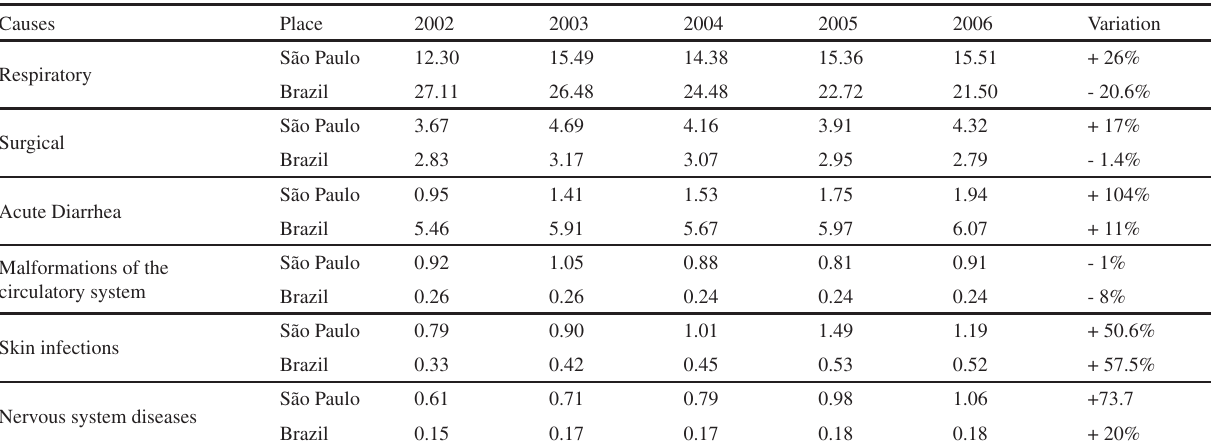
Table 4 - The hospitalization coefficients (per 1,000 children) for the major hospitalization causes in children one to four years old - São Paulo and Brazil, 2002 to 2006.